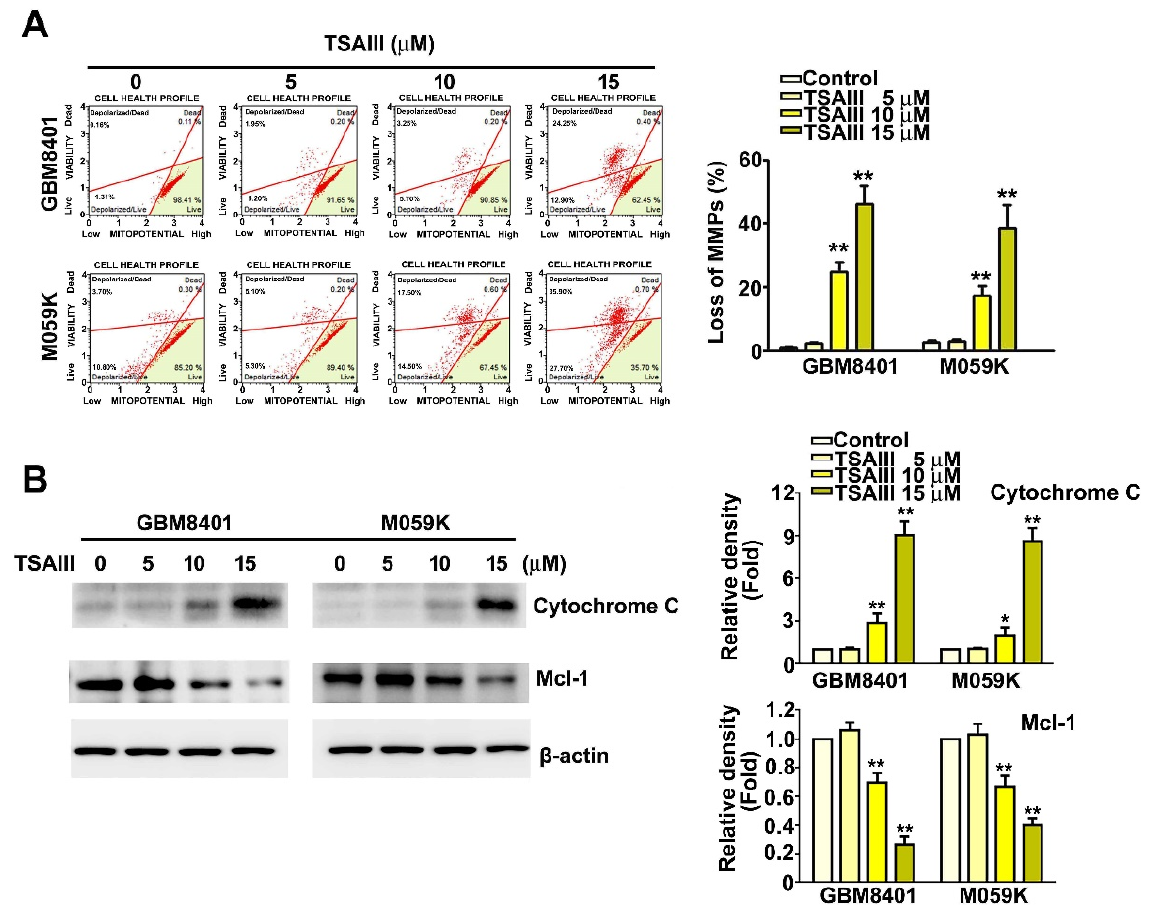
Figure 3. TSAIII induces mitochondrial dysfunction and expression of mitochondria-related proteins in human glioma cells. ( A ) Human glioma cells (GBM8401 and M059K) were treated with TSAIII (0, 5, 10, 15 µ M) for 24 h. Harvested cells were assessed for MMPs (mitochondrial membrane potentials) using MitoPotential reagent with flow cytometry. ( B ) Western blot assay of protein expression of Cytochrome C and Mcl-1 in GBM8401 and M059K cells treated with various concentrations of TSAIII (0, 5, 10, 15 µ M) for 24 h. Quantification of band density was performed using ImageJ. Each experiment was repeated three times, and data are presented as the mean ± SE. ** p < 0.01 vs. untreated cells (control).